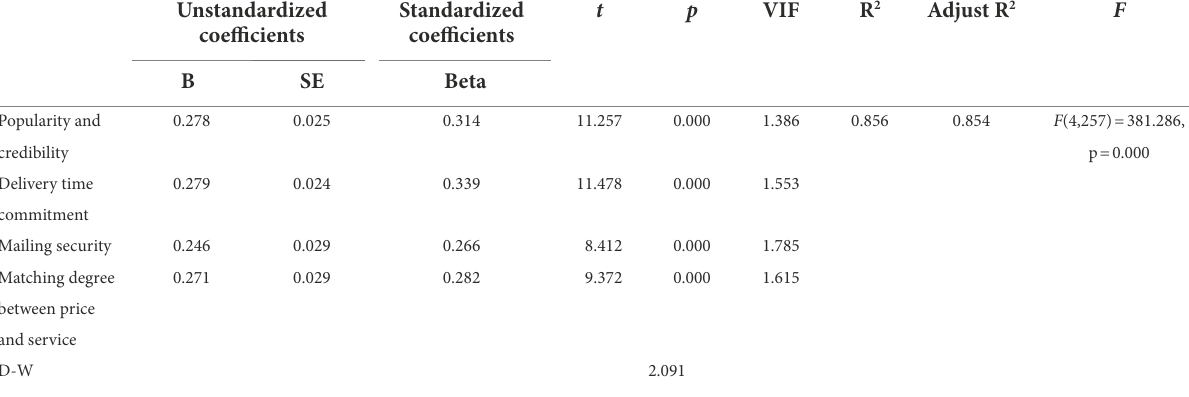
TABLE 9 Regression results of three-level indicators and expected service quality